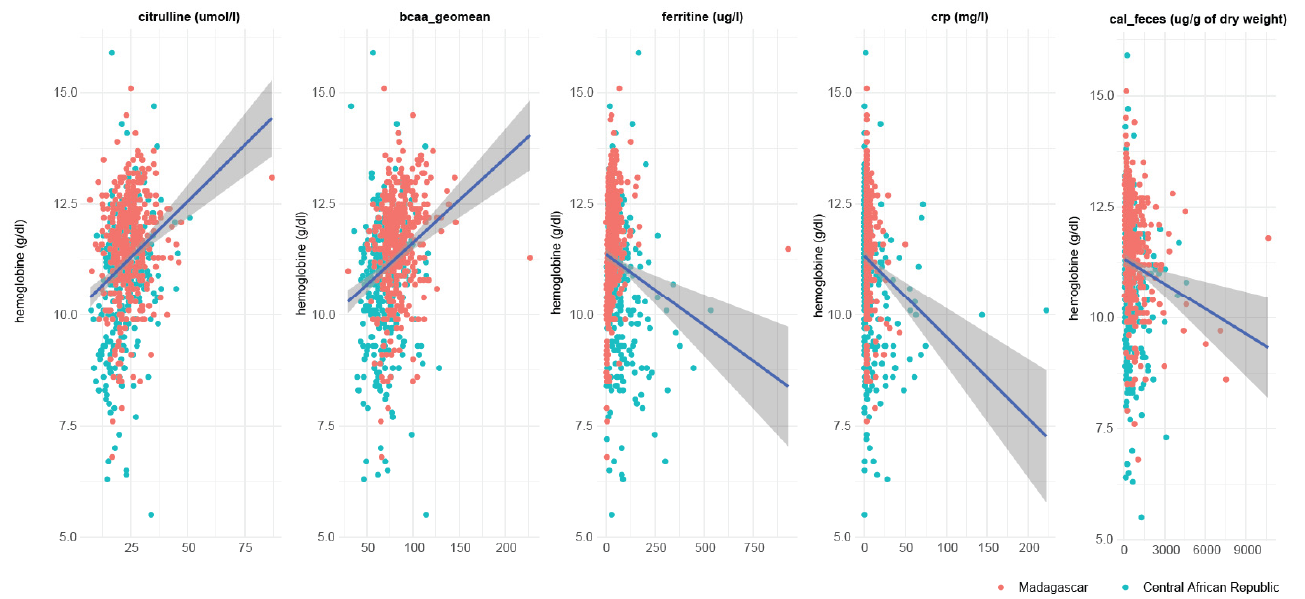
Figure 5. Correlation between putative EED biomarkers and hemoglobin levels.